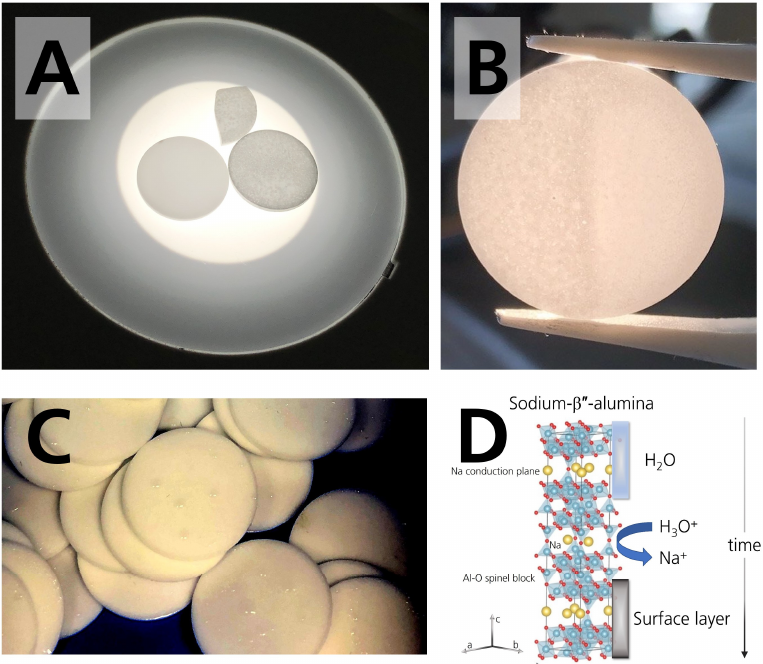
Figure 4. ( A ) Photograph of two disks and a disk fragment. The left disk was stored in the glovebox. It shows no stains or coloration. The disk on the right side is darkened after 28 days of storage in 44% r.h. The fragment is also darkened and belongs to a disk stored in 44% r.h. for 28 days. ( B ) Photograph of the colored specimen. Coloration can be removed by polishing, which was done on the right part of the specimen stored in 44% r.h. for 28 days. ( C ) Photograph of the droplets con- densing on the surface of the specimens stored in the desiccator with 96% r.h. The photograph was taken 21 days after initial storage. The photograph was adjusted for the brightness to visualize the droplets. ( D ) Scheme of sodium- β″ -alumina’s crystal structure and the occurring degradation mechanism when stored in a humid atmosphere. Adapted from [18], Copyright (2017), with permission from Elsevier.